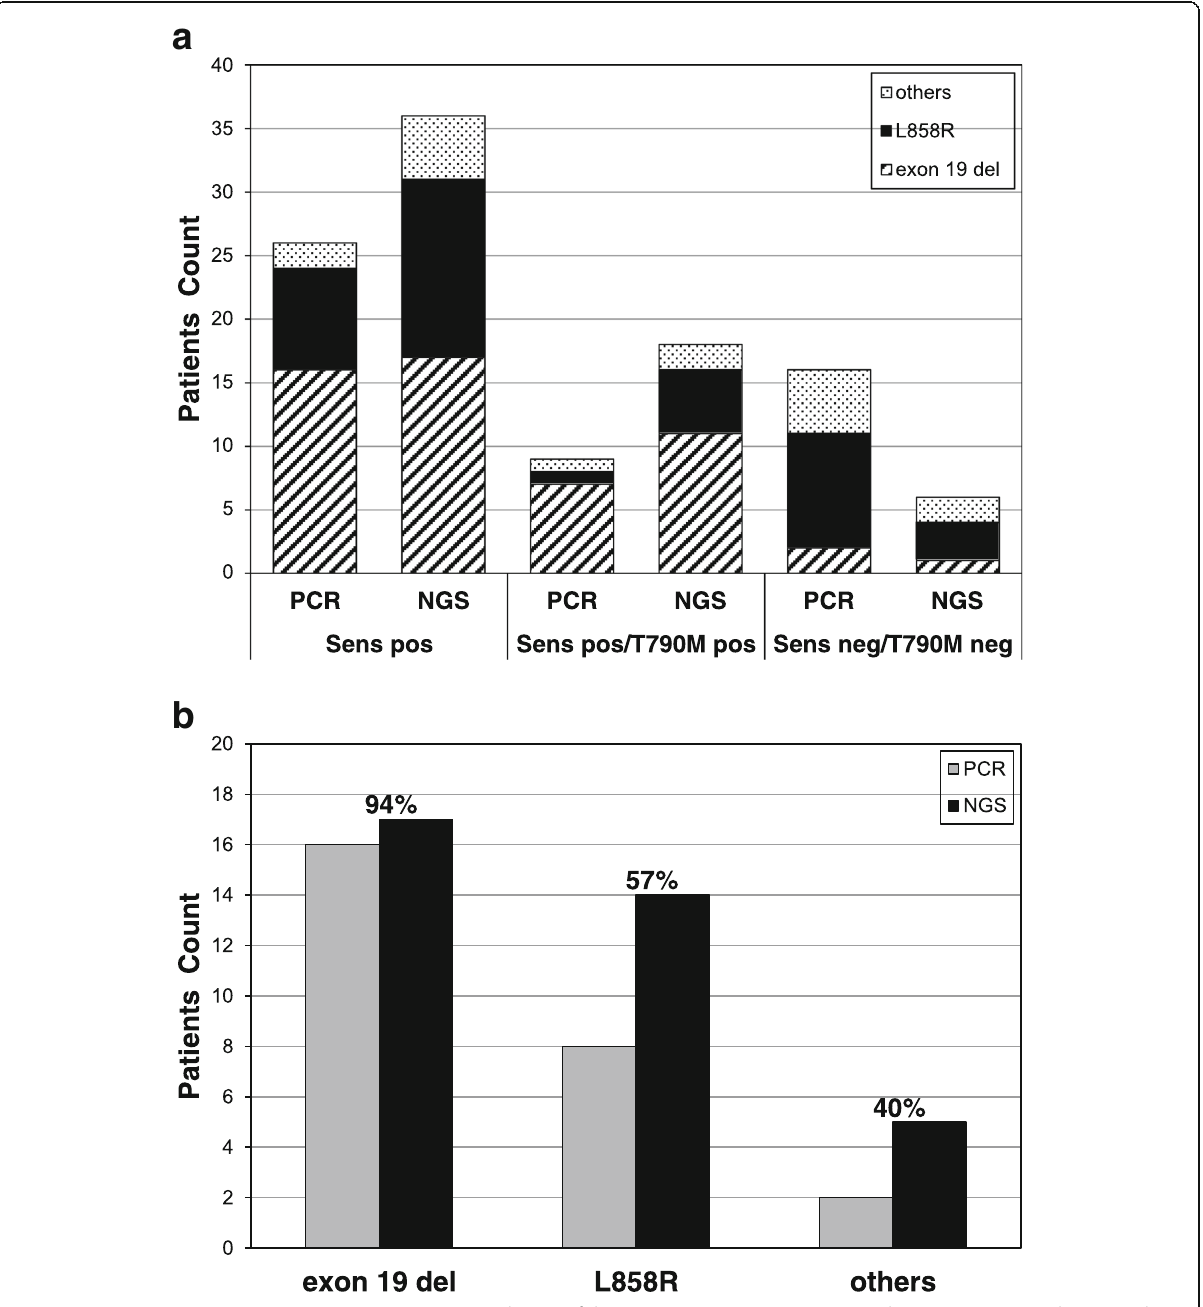
Fig. 1 EGFR mutations in 42 post-TKI NSCLC patients. ( a ) Distribution of the various EGFR mutations types in the 42 patients according to Real Time PCR (PCR) and tag-based NGS (NGS). The y-axis shows patients count according to different mutation patterns detected by the two platforms. ( b ) Coincident Rate between Real Time PCR (grey bars) and tag-based NGS (black bars) according to the different EGFR mutations types found. The y-axis indicated the number of cases concordant for the specific variation with both Real Time PCR and tag-based NGS and corresponding percentages are indicated within the histogram. PCR, Real Time PCR; NGS, tag-based NGS; del, deletions; Sens, sensitizing; pos, positive; neg,